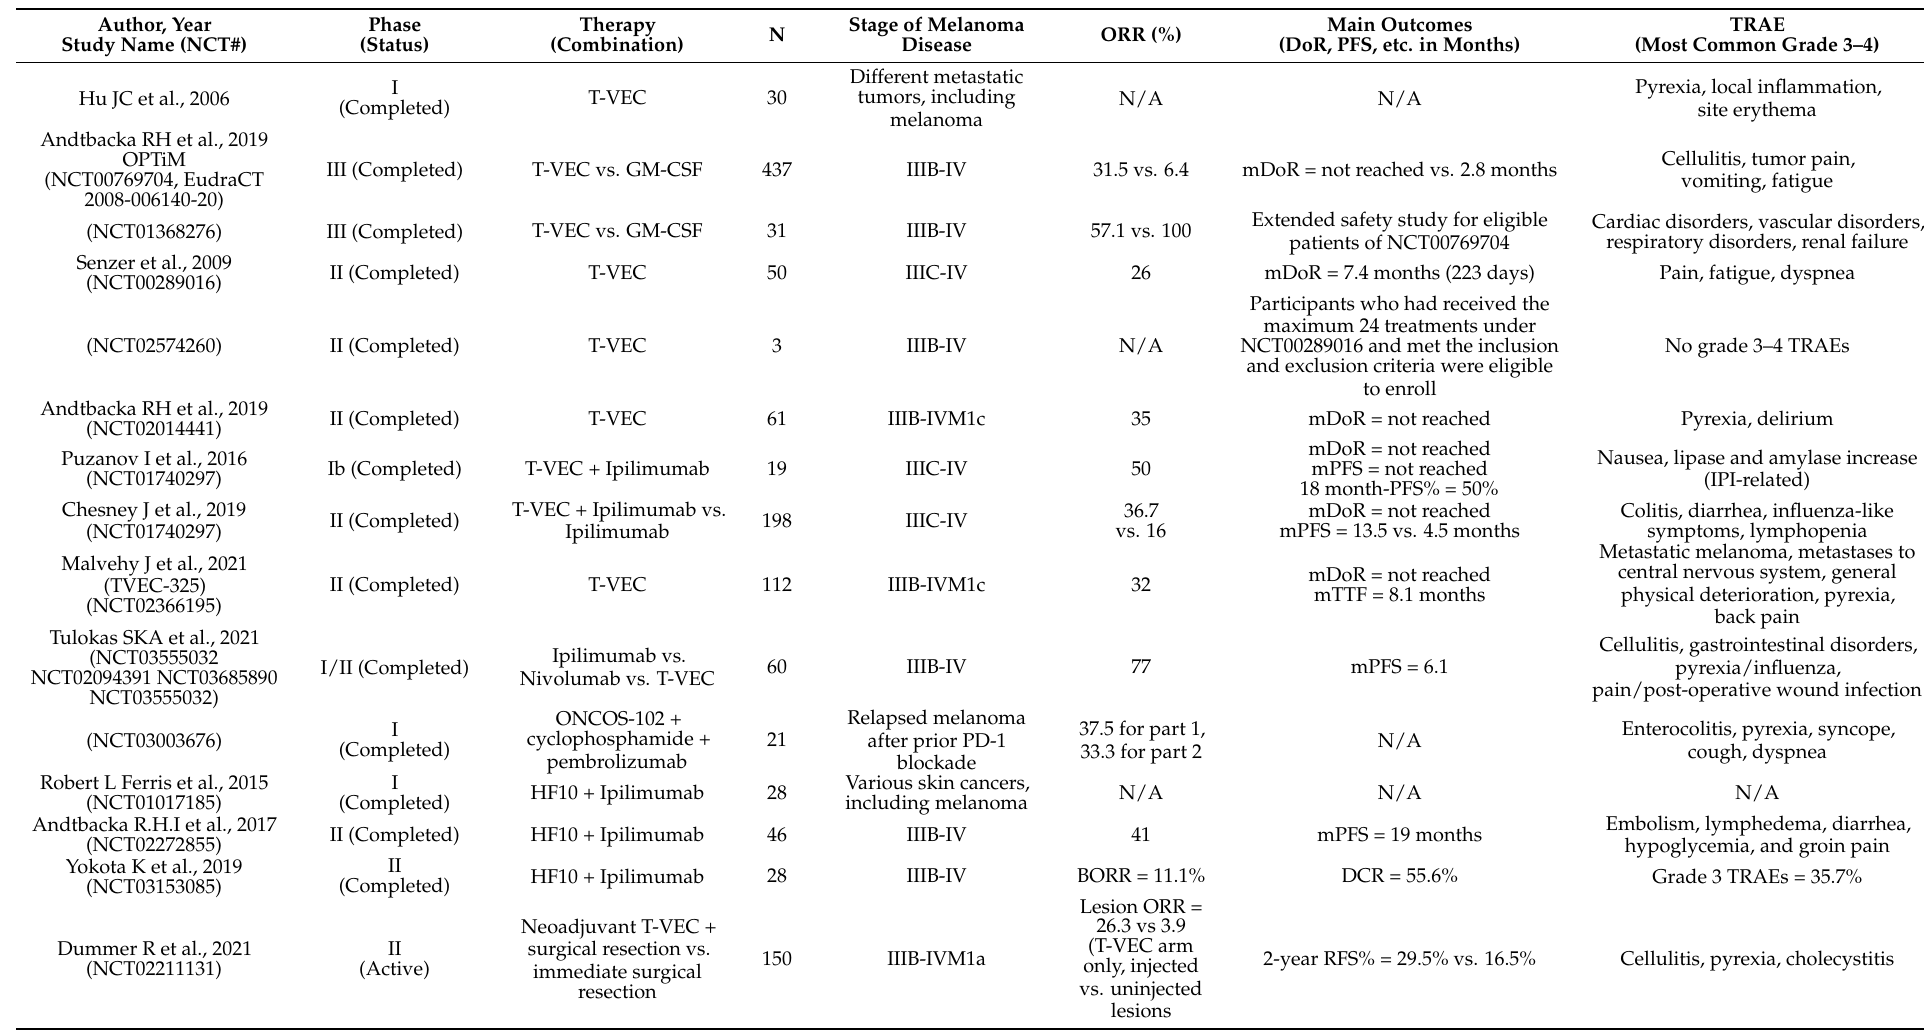
Table 2. Main clinical trials on OV regimens in melanoma patients and their reported